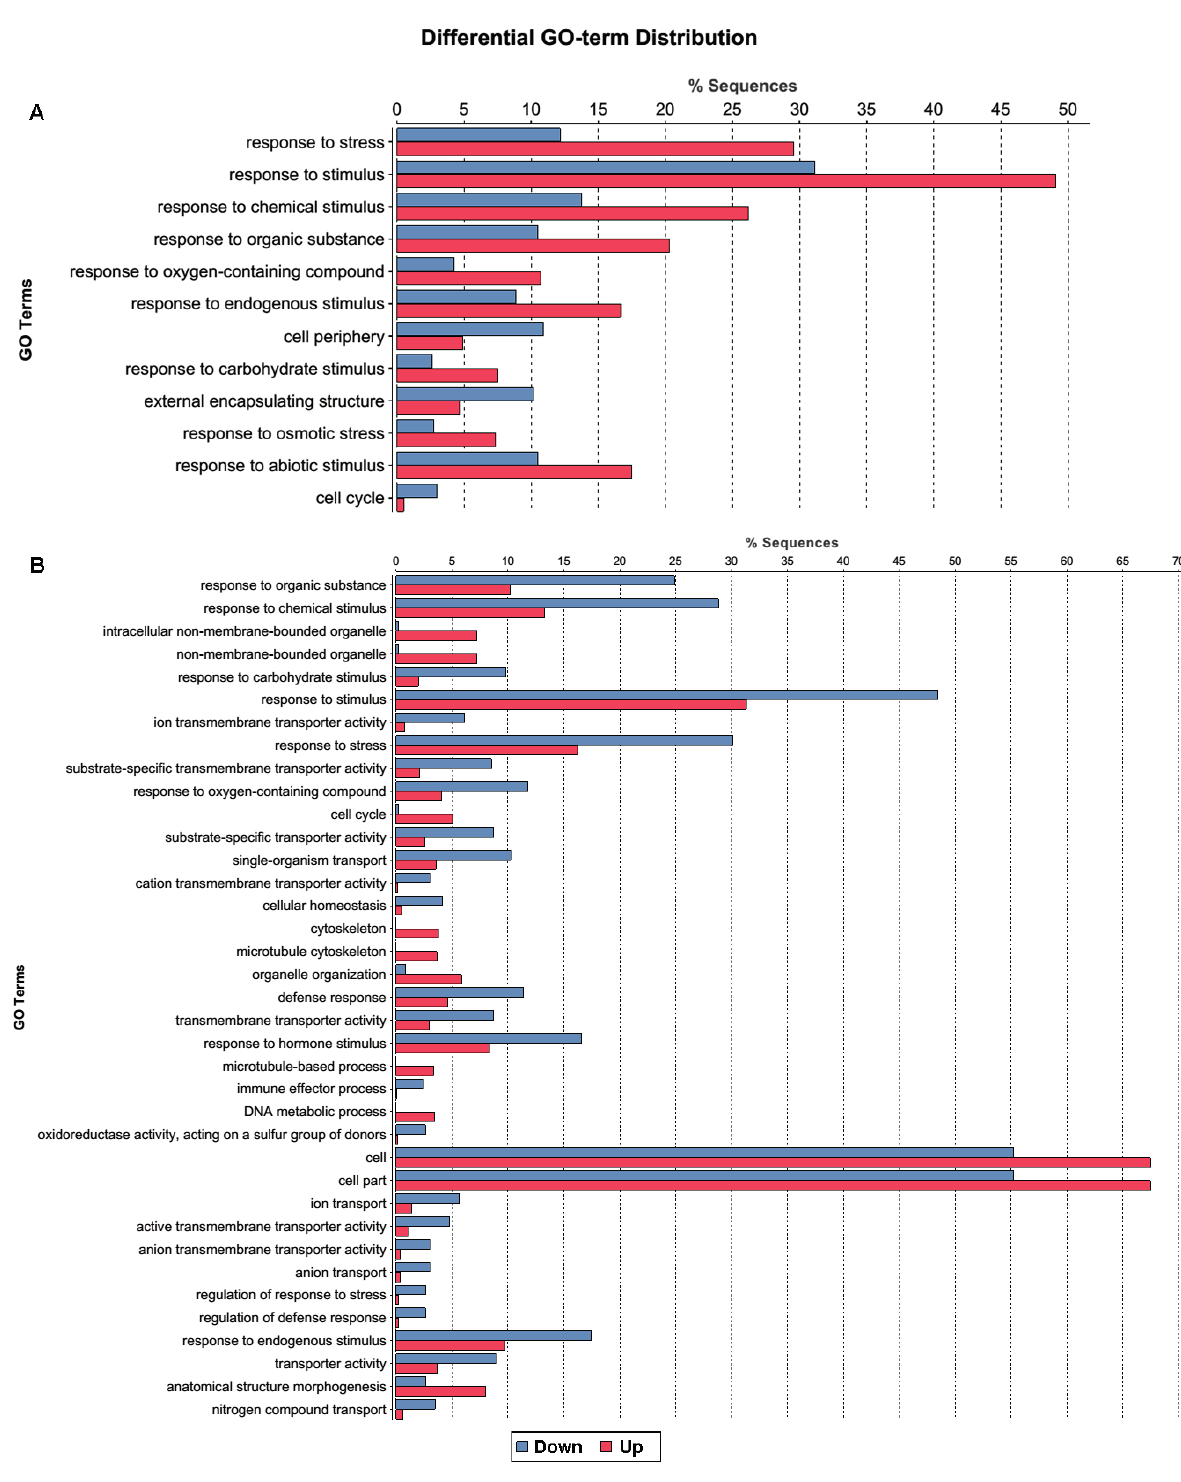
Figure 3. Statistical column diagram showing gene ontology (GO) annotation between up- and down-regulated differentially expressed genes (DEGs) in root ( A ) and leaf ( B